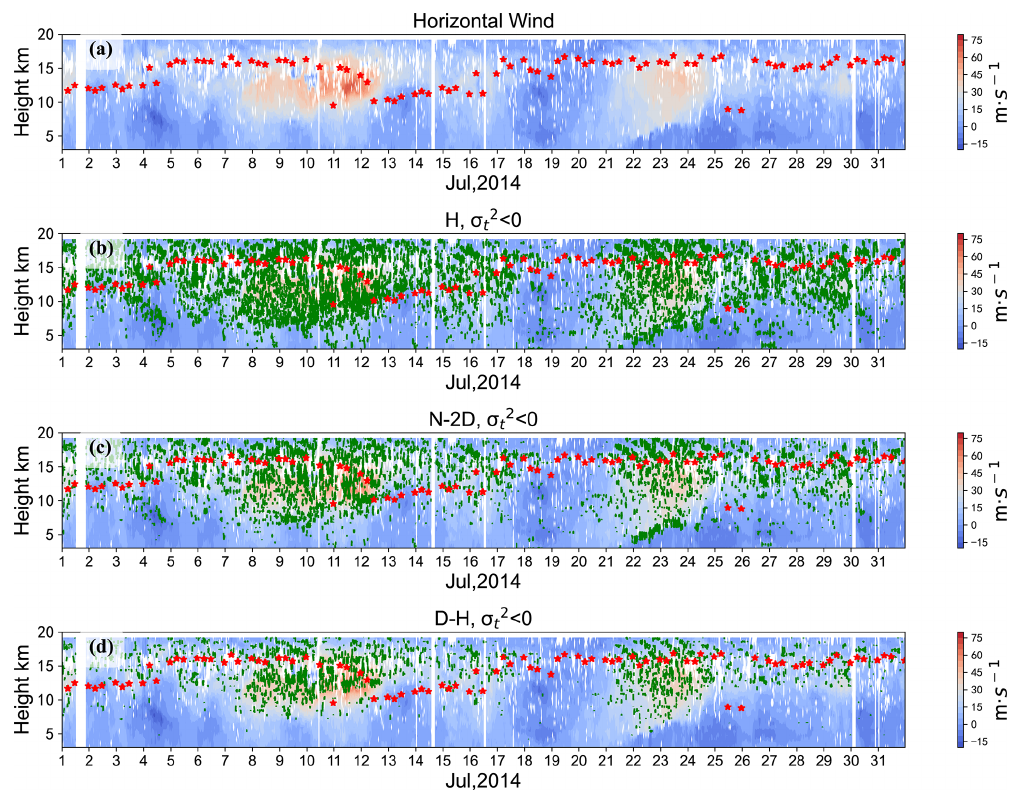
Figure 6. N-TKE distribution of three models over the Beijing MST radar site in July 2014: (a) the east–west component of horizontal wind; (b–d) area of N-TKE (green shading) for the east beam using the (b) H model, (c) N-2D model and (d) D–H model. The red scattered points are the tropopause. Table 3. Turbulence parameters of the Beijing MST radar (39.78 ◦ N, 116.95 ◦ E) at the range of 3–19.8km. H model, c 1 = 0 .